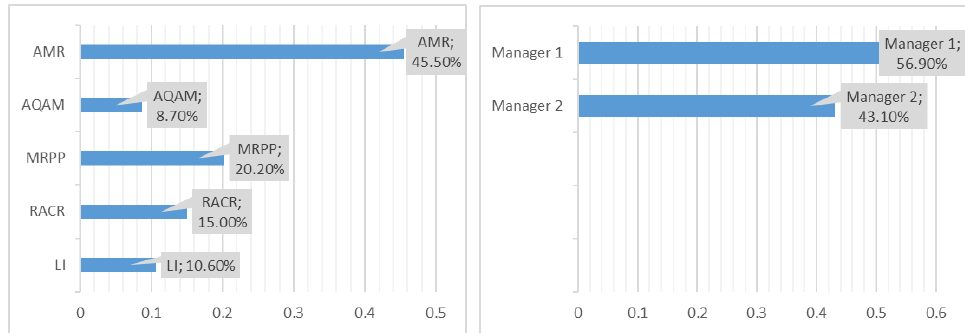
Figure 3. Scenario 1 (own processing).